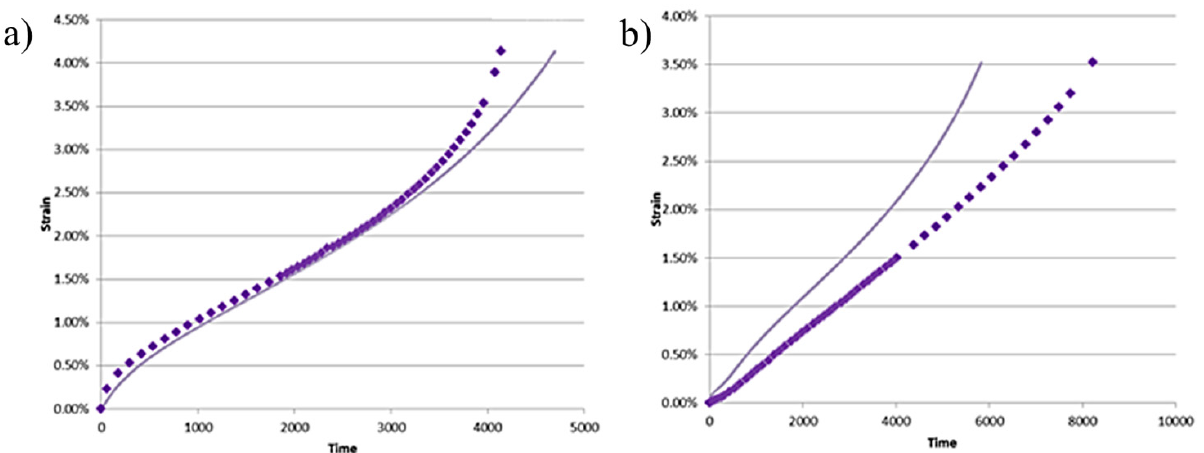
Figure 5. Pure Copper New Model Prediction: ( a ) 52.8 MPa 688 K; and ( b ) 27.6 MPa 774 K. Experimental data ( ♦ ) model prediction ( ▬